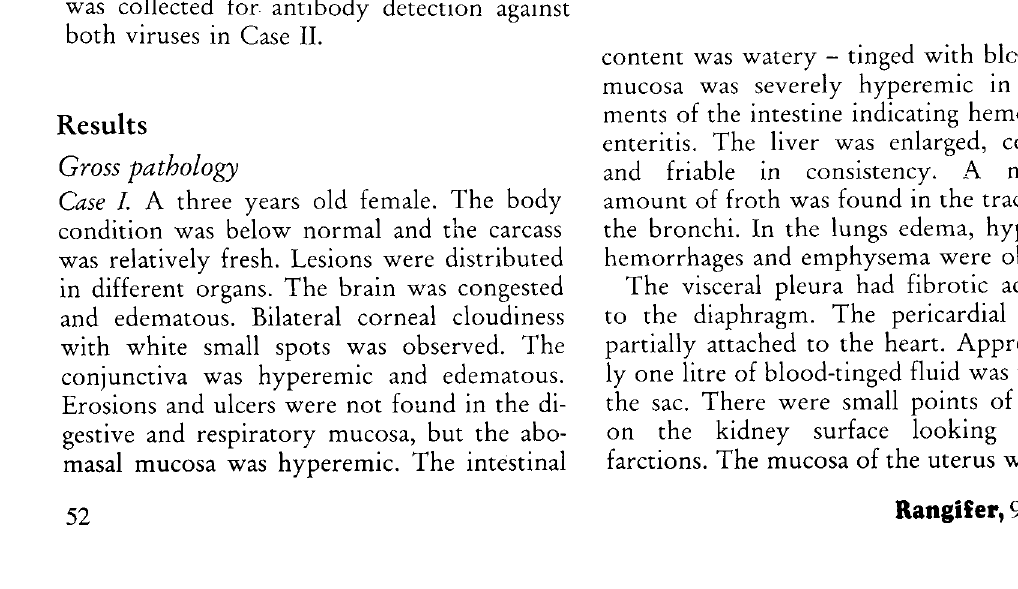
Figure 2. Case II. Muco-purulent discharge coming out from the nostril